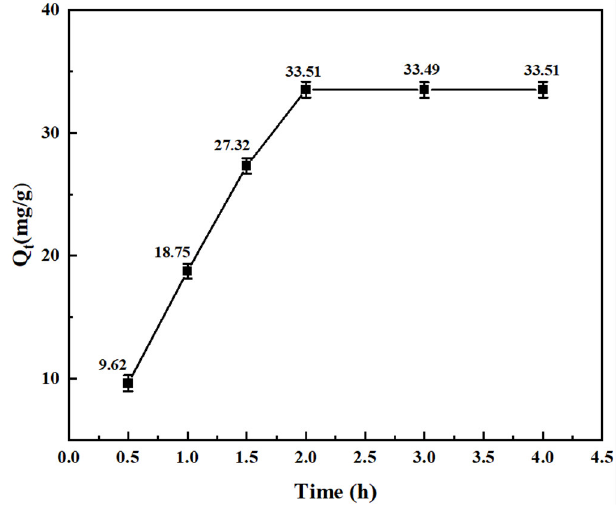
Figure 11. Effects of contact time on the adsorption of Cu 2+ onto SA-Ch.